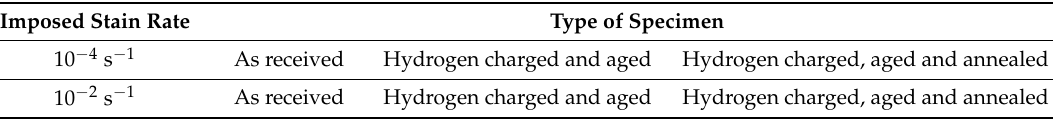
Table 1. Type of tested specimens at different imposed strain rates.